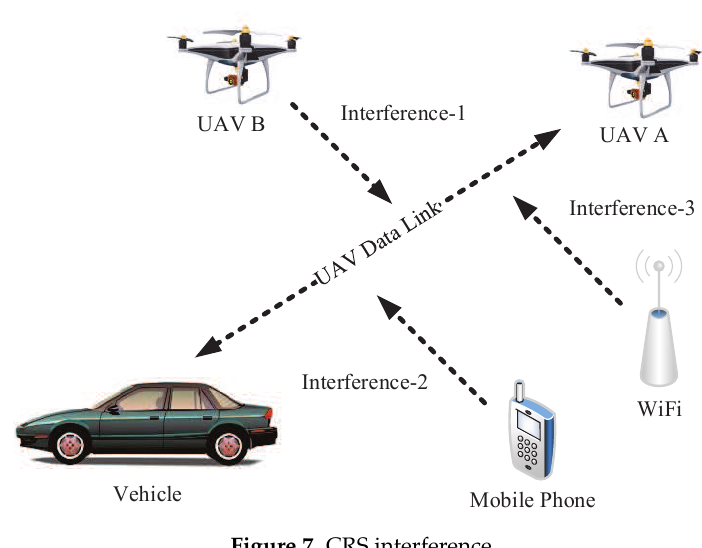
Figure 7. CRS interference.